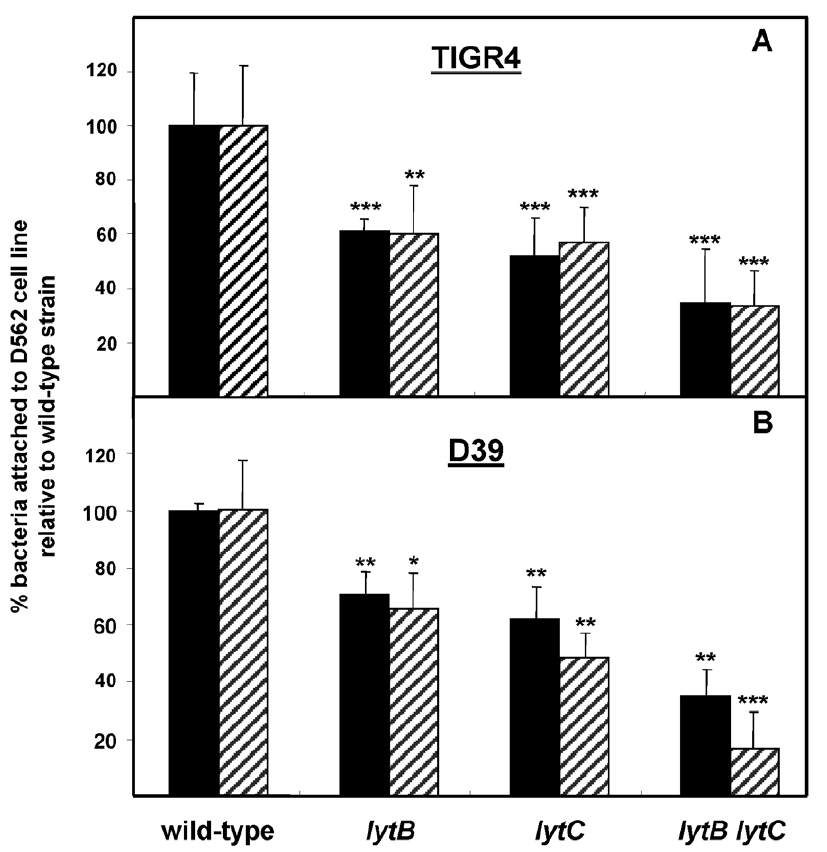
Figure 1. Proportion of bacteria recovered from D562 cells infected with wild-type or defective strains in CWHs. D562 cells were incubated at 37 u C (solid bars) or 30 u C (hatched bar). Error bars represent the SDs, and asterisks mark results that are statistically significant compared with wild-type strains (two-tailed Student’s t test; *, P , 0.05; **, P , 0.01; ***, P , 0.001). (A) TIGR4 strain and isogenic mutants. P , 0.01 ( lytB vs. lytB lytC ) and P =0.09 ( lytC vs. lytB lytC ) (Student’s unpaired t test, 2-tailed). P , 0.001 for the overall comparison (one-way ANOVA with a post hoc Dunnett test). (B) D39 strain and isogenic mutants. For the lytB lytC double mutant vs. lytB or lytC single mutants: P , 0.001 (Student’s unpaired t test, two-tailed). P , 0.001 for the overall comparison (one-way ANOVA with a post hoc Dunnett test).